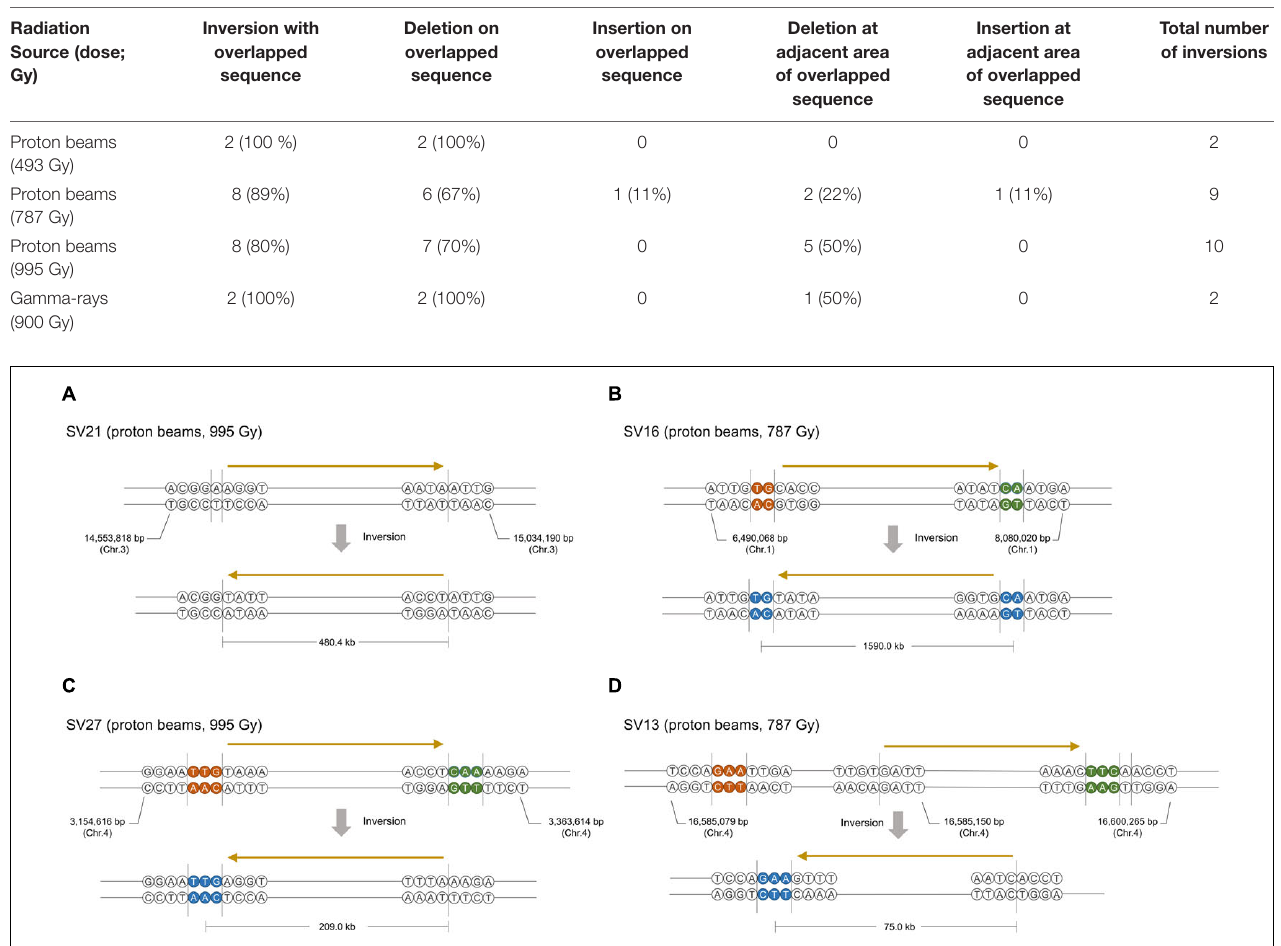
FIGURE 7 | Representative typesFigure of inversions induced by proton beam irradiation. (A) Inversion without microhomologous sequences and deletion on rearrangement junctions. (B) Inversion with microhomologous sequences and without deletion. (C) Inversion with microhomologous sequences and deletion of a few nucleotides near or on microhomologous sequences. (D) Inversion with microhomologous sequences and deletion of 10 s to 100 nucleotides on the adjacent region of rearrangement junctions. Brown and green circles indicate the microhomologous sequences on each rearrangement site in the original molecule. Blue circles in the inversion products indicate nucleotides that may have originated from any microhomologous sequences in the original molecule. The ranges of DNA regions in which DNA breaks or end-joining could occur are indicated by vertical lines. The relative direction of the DNA region is indicated by arrows above the DNA